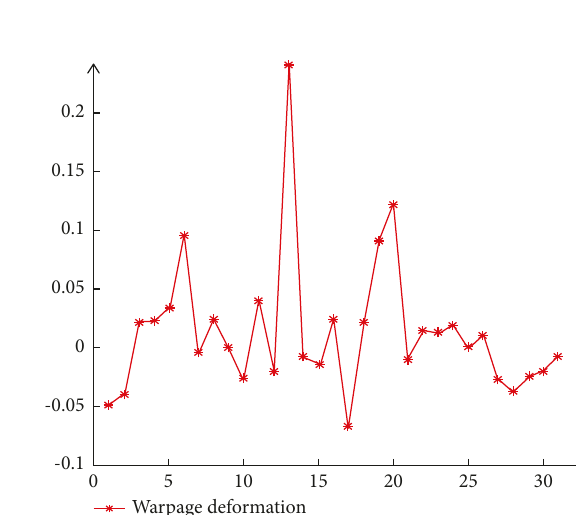
Figure 23: Warpage prediction error